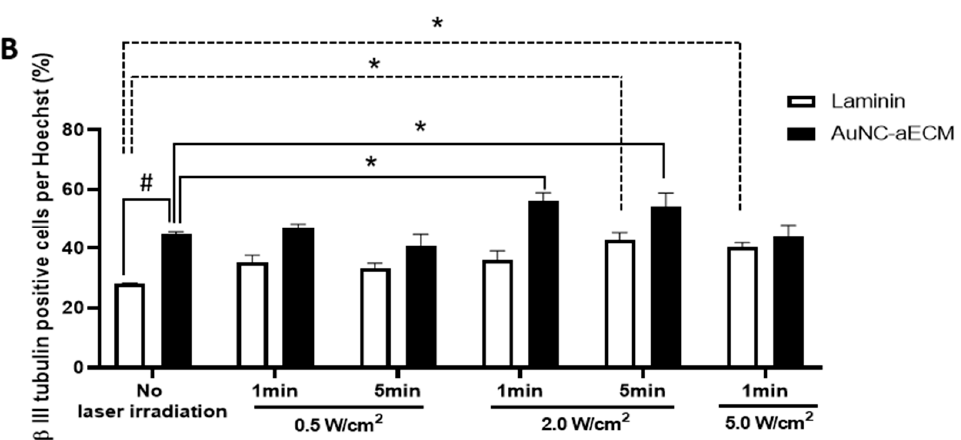
Figure 3. Neuronal differentiation of rNSCs grown on laminin-coated glass coverslips and AuNC-aECMs with/without laser irradiation. rNSCs were seeded onto both laminin-coated glass coverslips and laminin-coated AuNC-aECMs and after 2 days, cells were treated with indicated laser irradiation parameters (0.5–5.0 W/cm 2 for 1–5 min). After 14 days, cells were analyzed with immunostaining assay ( A , B ). Differentiated neuron and astrocyte cell populations were identified with β -III-tubulin (neuron marker) and GFAP (astrocyte marker). Values represent the means ± SDs of three independent experiments. # p values < 0.05 vs. the control group (laminin-coated glass coverslip). * p < 0.05 vs. laminin-coated AuNC-aECM in the absence of laser irradiation group.